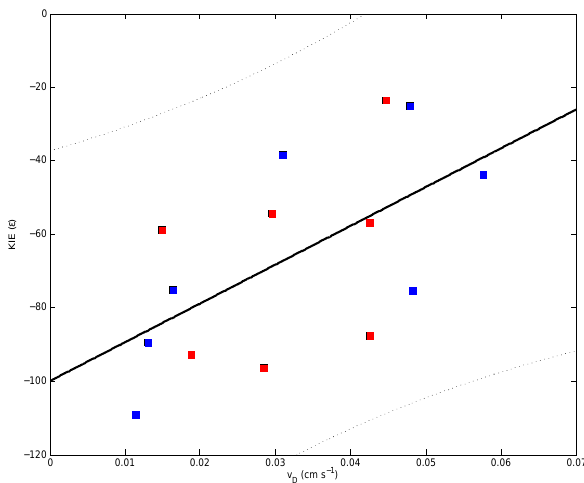
Fig. 4. The correlation of deposition velocity and kinetic iso- tope effect for chamber experiments conducted during winter (blue squares) and summer (red squares) seasons. Linear fit shown (solid line) with 95% confidence interval (dotted line) is indicative of a relationship between the two variables ( r 2 = 0 . 27, p < 0 .